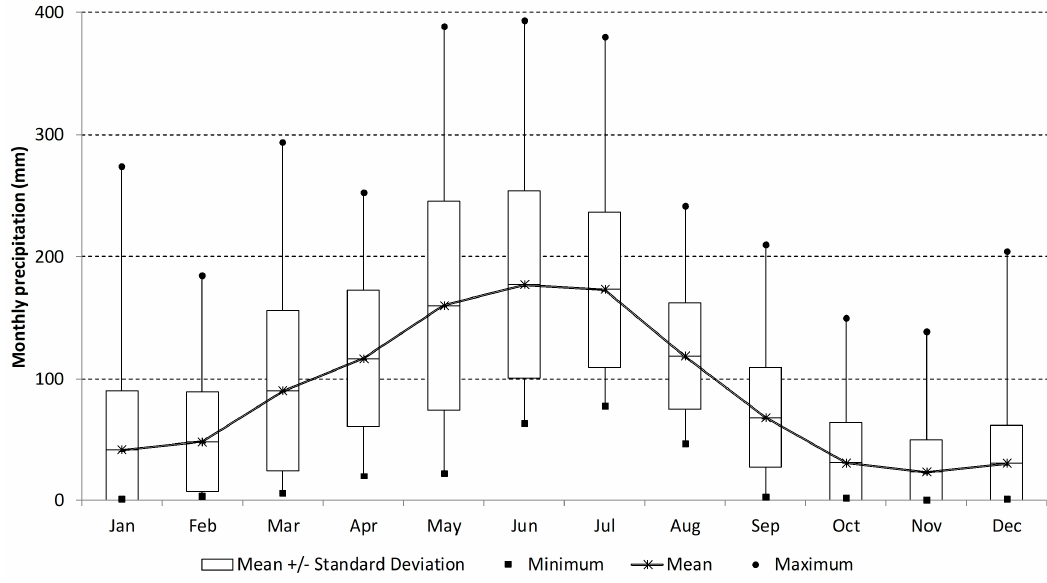
Figure 2. Monthly average precipitation (from 1938 to 2008) over the study area from the 18 selected precipitation stations with the degree of dispersion.